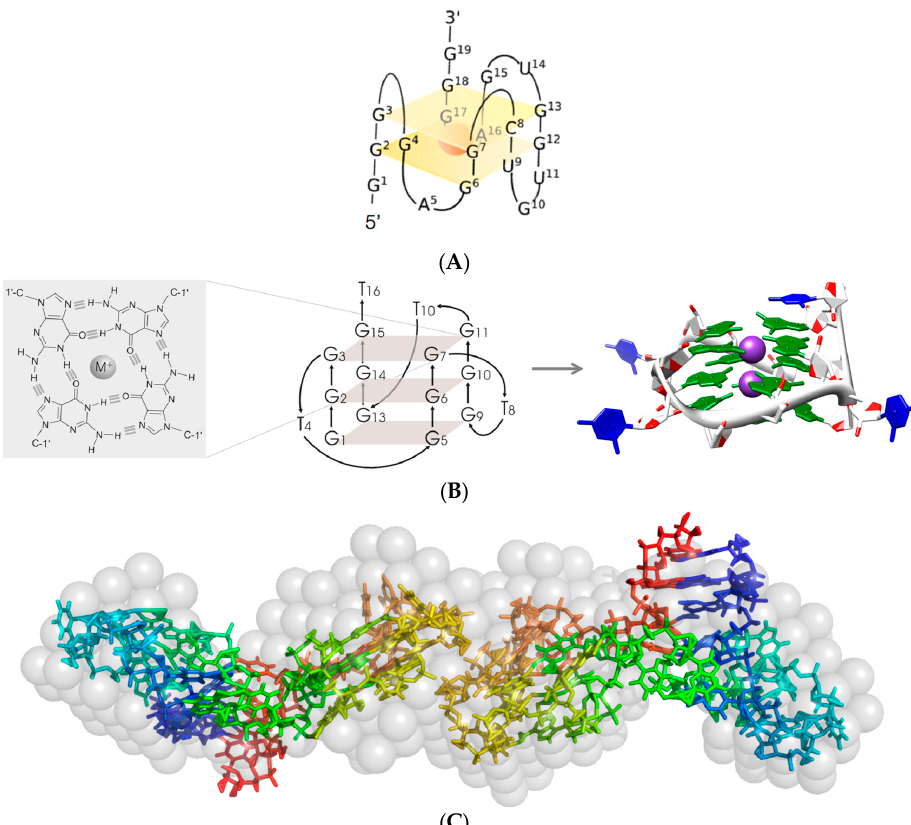
Figure 3. Aptamers AIR-3A, AID-1 as well as RAID3 all exhibit a G-quadruplex structure; the RNA aptamers AIR-3A and RAID3 were shown to dimerize. Circular dichroism (CD) spectroscopic investigations and UV-melting analyses revealed a G-quadruplex structure for both the RNA aptamers AIR-3A ( A ) [4] and RAID3 ( C ) [6], as well as for the DNA aptamer AID-1 ( B ) [7]. Balls in B represent structure stabilizing metal ions; gray semitransparent spheres in C symbolize a model deduced from synchrotron-based small-angle X-ray scattering (SAXS) analyses which could be superimposed with an ab initio model of an aptamer